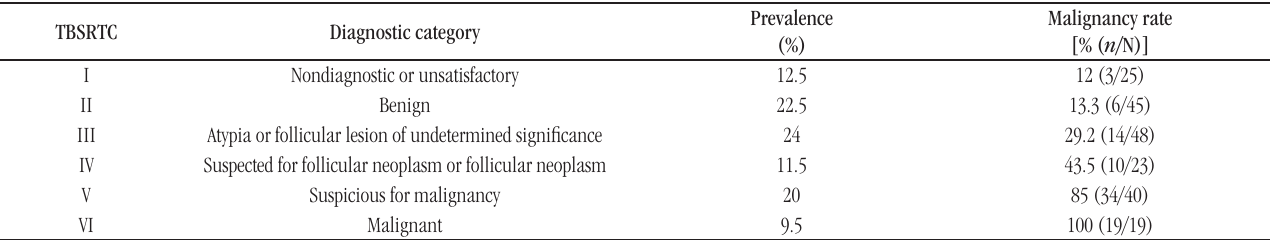
taBLE 1 − Distribution of diagnoses derived from thyroid FNA according to TBSRTC categories and corresponding malignancy rates observed in the histological analysis TBSRTC